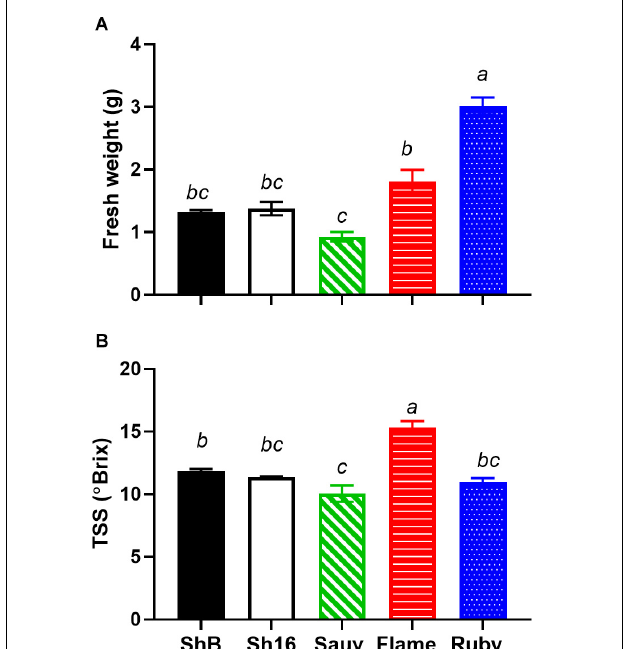
FIGURE 1 | Sugar accumulation of Shiraz BVRC12 (ShB) and 1654 (Sh16), Sauvignon Blanc (Sauv), Flame Seedless (Flame), and Ruby Seedless (Ruby) during season 2017/2018. Total soluble solids (TSS) were measured and are shown as means ± s.e.m. ( n = 5). Where separate lines are shown this indicates that there was a significant difference between the fitted lines (logistic growth, Akaike information criterion).